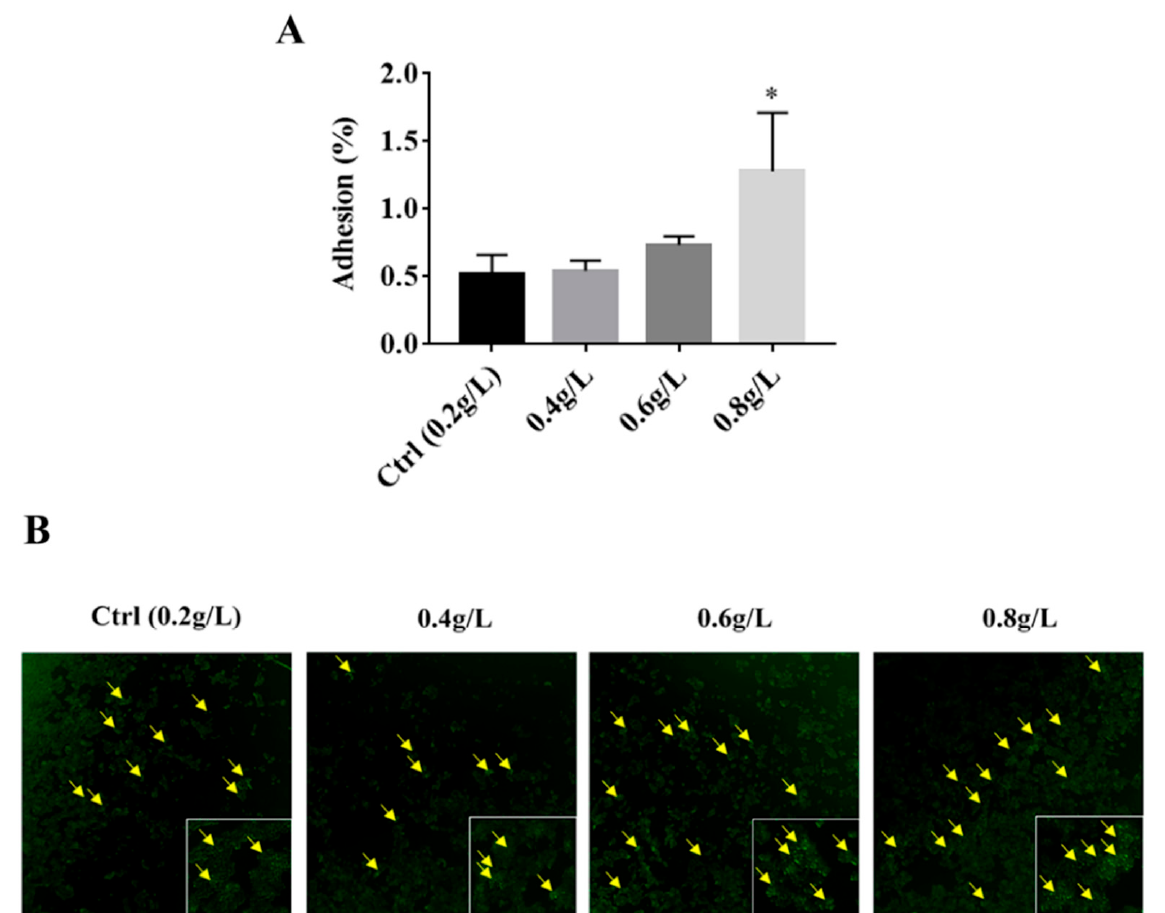
Figure 3. Effects of 0.2, 0.4, 0.6, and 0.8 g/L of tryptophan on adhesion of A. muciniphila BAA-835 T . ( A ) Adhesion to HT-29, and ( B ) CFDA-SE-labeled A. muciniphila BAA-835 T adhere to HT-29. One-way ANOVA with a post hoc Dunnett test was used to determine statistical differences, compared with the Ctrl group. * p < 0.05.